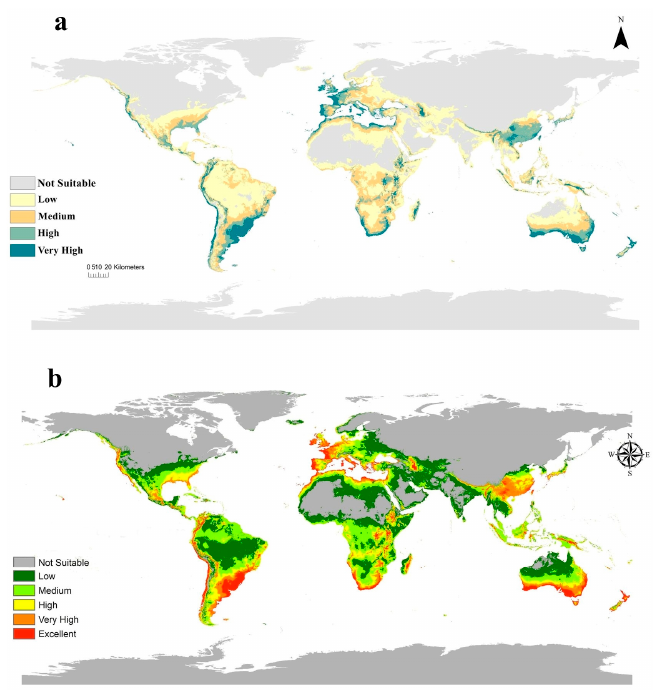
Figure 3. Current potential global distribution of C. albiceps : ( a ). Using maxent and ( b ). using